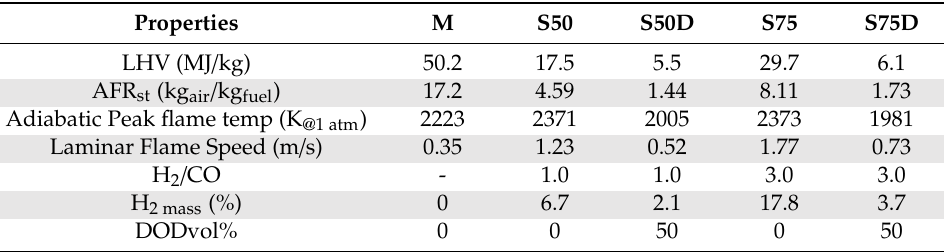
Table 3. Main properties of the fuels used for the study.